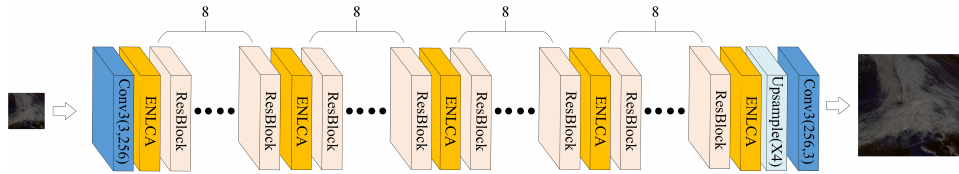
Figure 7. Structure of the efficient non-local contrastive attention (ENLCA)